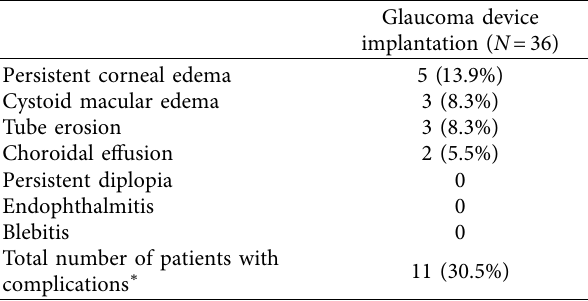
Table 4: Late postoperative